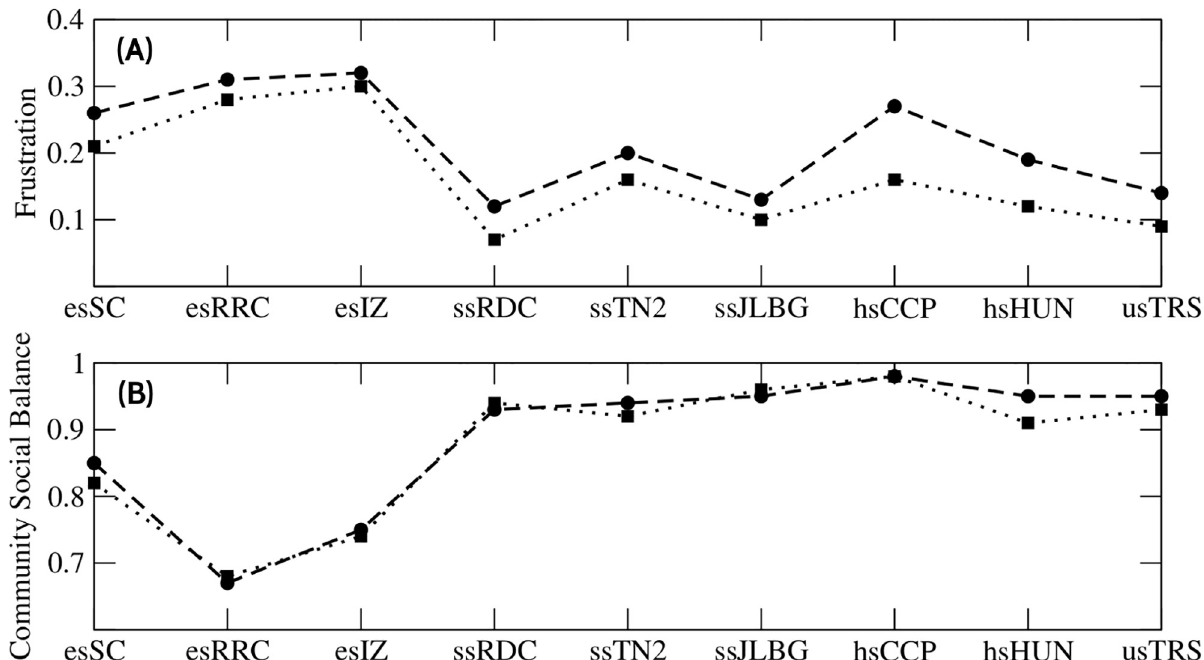
Fig 8. CSB and frustration. (A) Frustration values for Newman (circles) and greedy (squares) methods. (B) CSB (community social balance) values for Newman (circles) and greedy (squares) methods. Each greedy value was obtained after 300